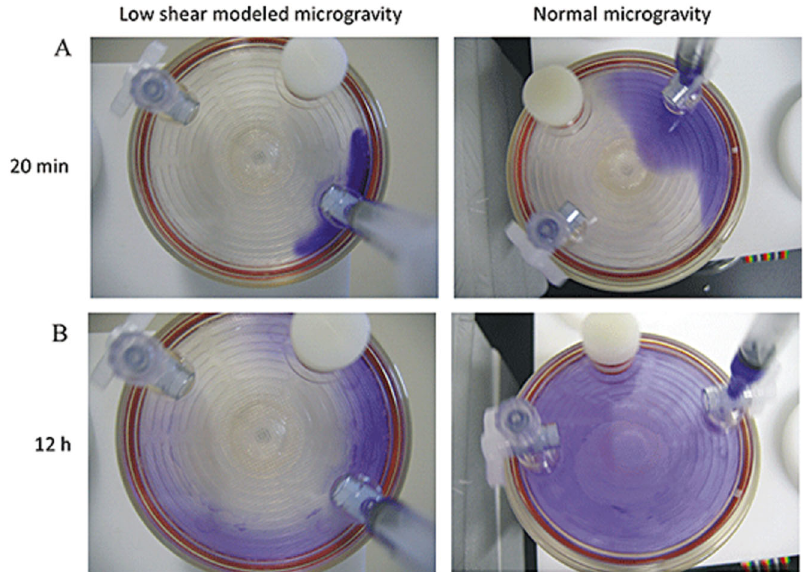
Fig. 4 HARV bioreactors injected with crystal violet. (Left) Under simulated microgravity, the dye stays along the outer wall before gradually migrating inward. (Right) The dye spread under normal gravity. Reprinted from Crabbe et al. 65 with permission from John Wiley and Sons with no